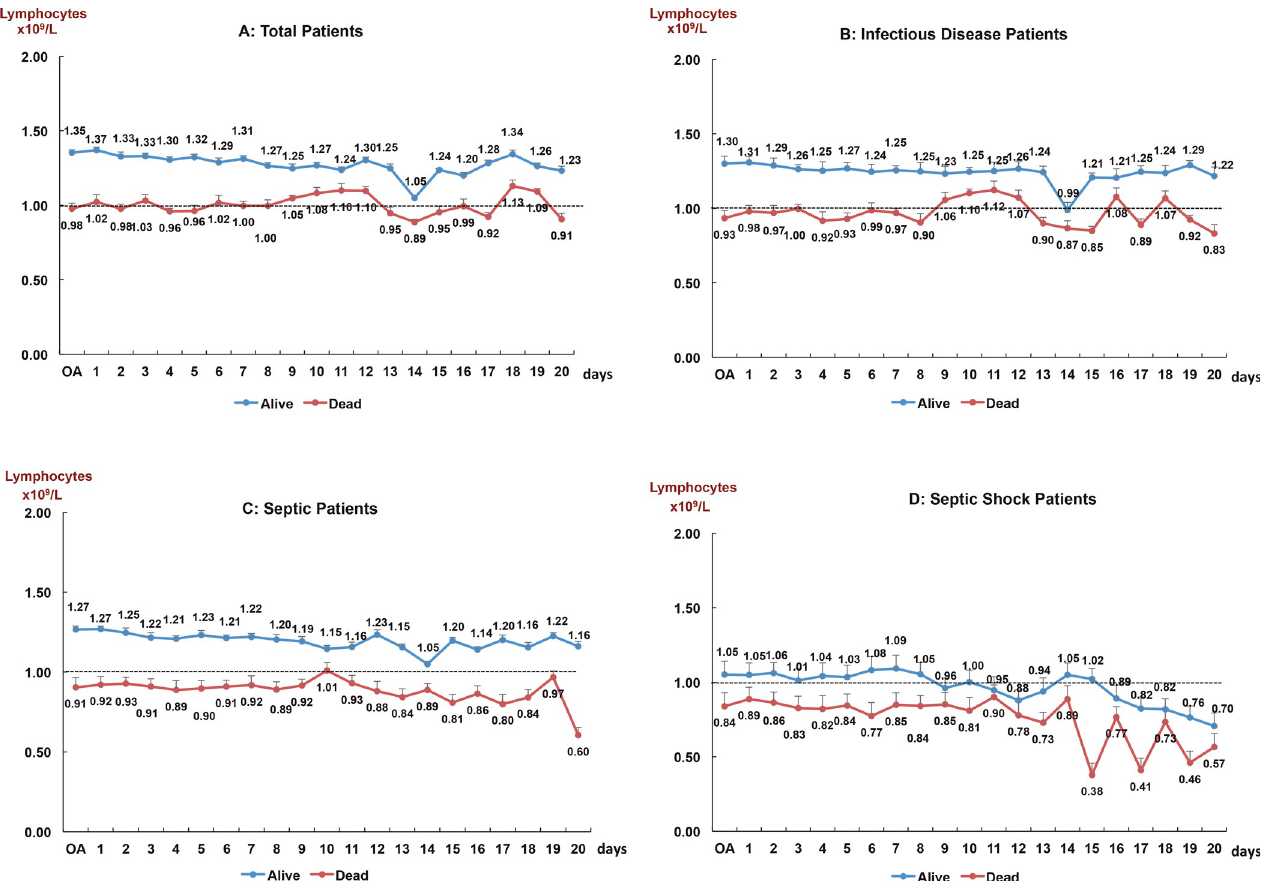
Fig 1. Evolution of absolute lymphocytes counts (mean) according to alive and dead patients in the consecutive days analyzes performed (1 to 20 days) during the hospital stay, in four situations: All cases, infectious pathology, sepsis and septic shock. OA: On Admission. Lymphopenia— < 1.0 x10 9 /L. Repeated Measures ANOVA (p < 0.05). T-bars show typical error. Significative differences (Mann-Whitney U test) between alive and dead: Total patients; Infectious Diseases and Sepsis ( p < 0.001); Septic Shock: days 1 to 10 ( p < 0.001), days 11 to 15 ( p < 0.05); days 16 to 20 no significant.